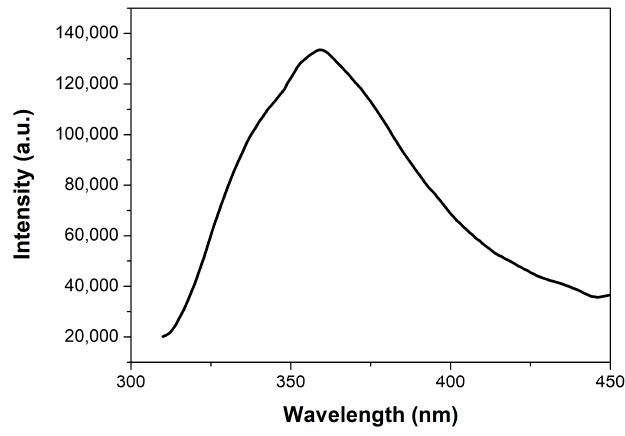
Figure 2. Solid-state fluorescence spectrum of 1 at room temperature.